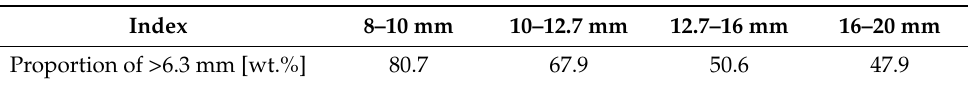
Table 7. LTD values for different-sized pellets.